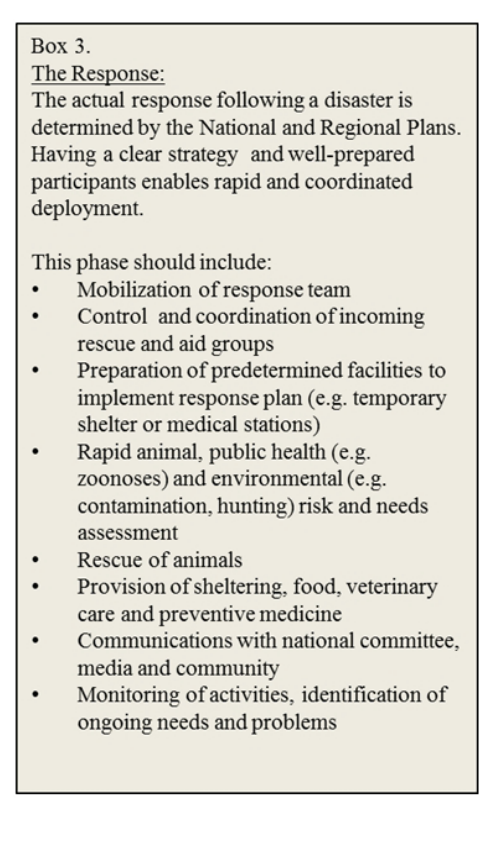
Figure 3. Description of the ground response immediately following a disaster with examples of typical operations.